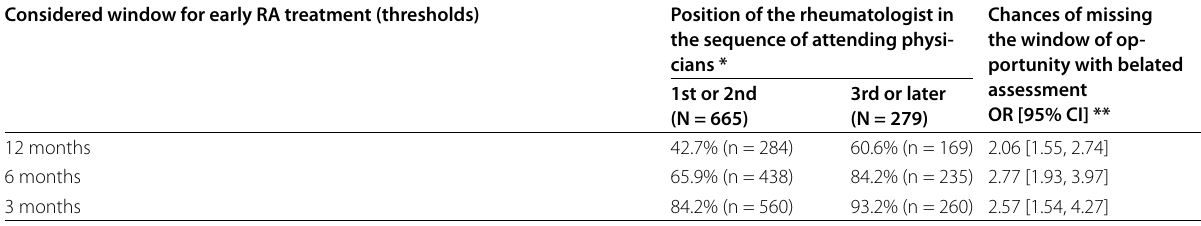
Table 3 Missed opportunities for early RA treatment according to access to the rheumatologist in the diagnostic journey Considered window for early RA treatment (thresholds) Position of the rheumatologist in